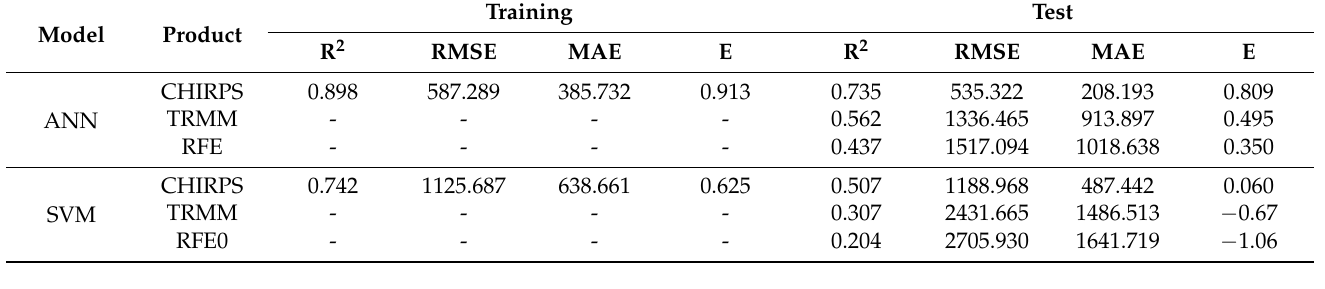
Table 3. Performance measures of ANN and SVM models for measured and forecasted monthly streamflow.